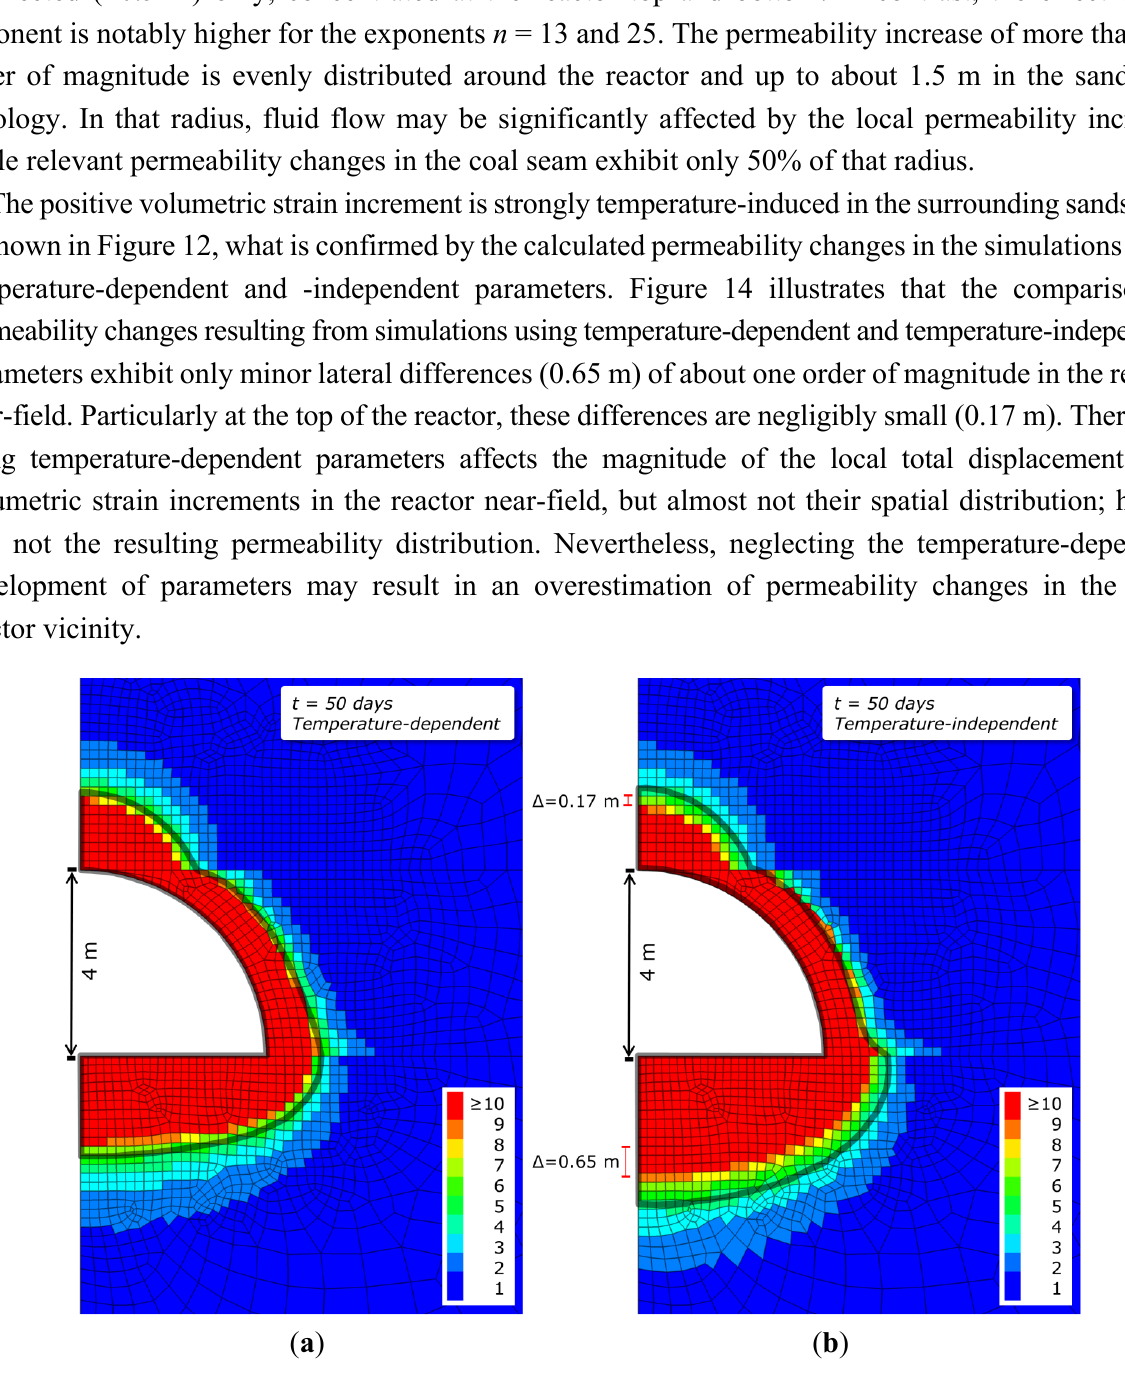
Figure 14. Permeability changes ( − ) show negligible differences for ( a ) temperature-dependent and ( b ) temperature-independent parameters. The difference in regions of high permeability increase is only marginal, extending to 0.17 m above and 0.65 m below the reactor. The grey solid line represents the 200 °C